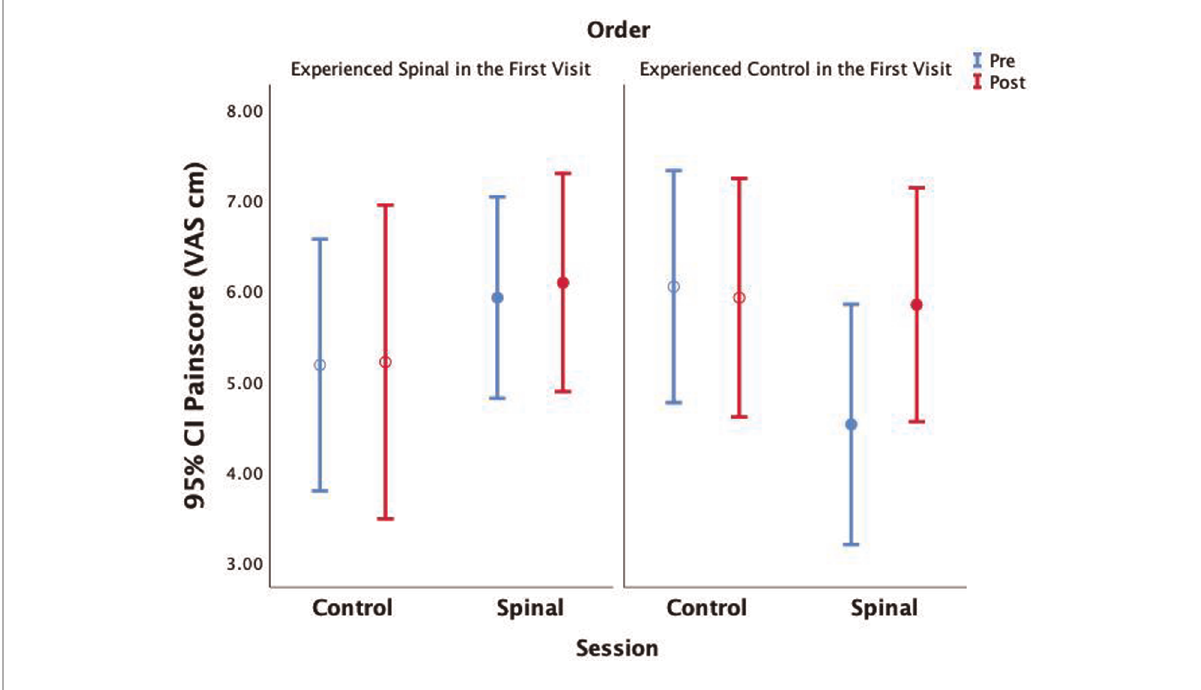
FIGURE 6 Average pain scores are shown without accounting for within subject parameter estimation across time and session.